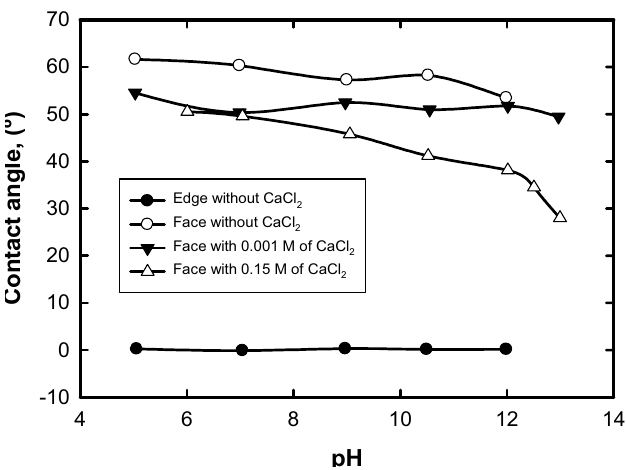
crystal (López-Valdivieso et al., 2006) 31) 2